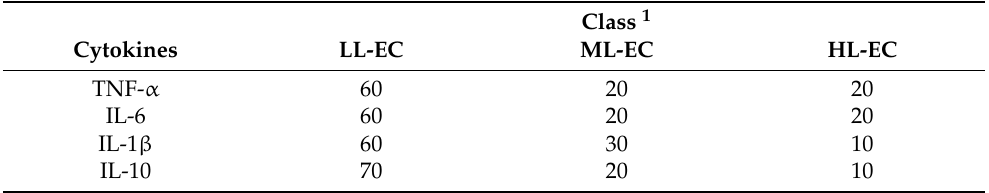
Table 2. Percentage distribution of children with epilepsy grouped according to levels of different cytokines in peripheral blood mononuclear cell